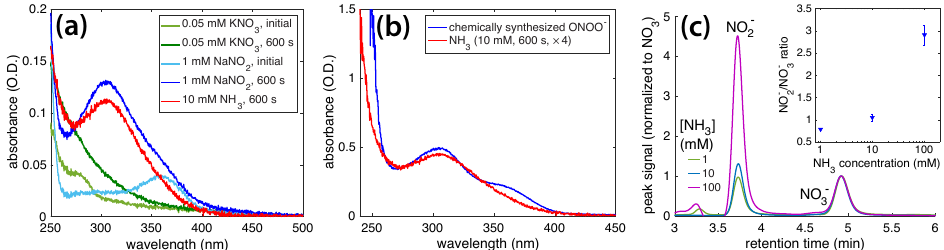
Figure 6. ( a ) Absorption spectra of initial and irradiated KNO NH for comparison; ( b ) Absorption spectra of irradiated NH 3 ( c ) Ion chromatograms overlaid for 1, 10, and 100 mM NH normalized to NO – peak (labeled). Inset shows NO − 3 NH 3